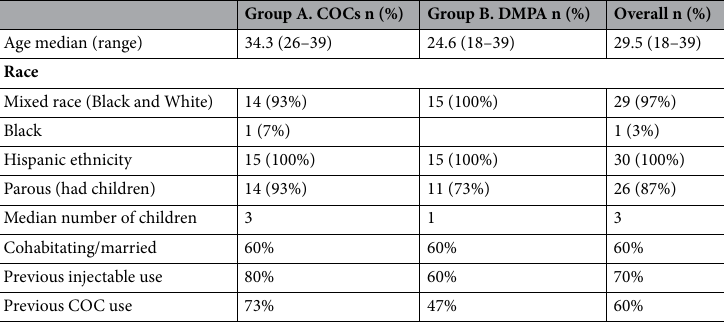
Table 2. Demographic characteristics of study participants by group (N = 30).